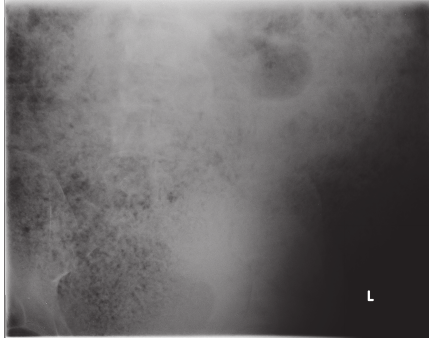
Figure 1: Plain preoperative abdominal radiograph.